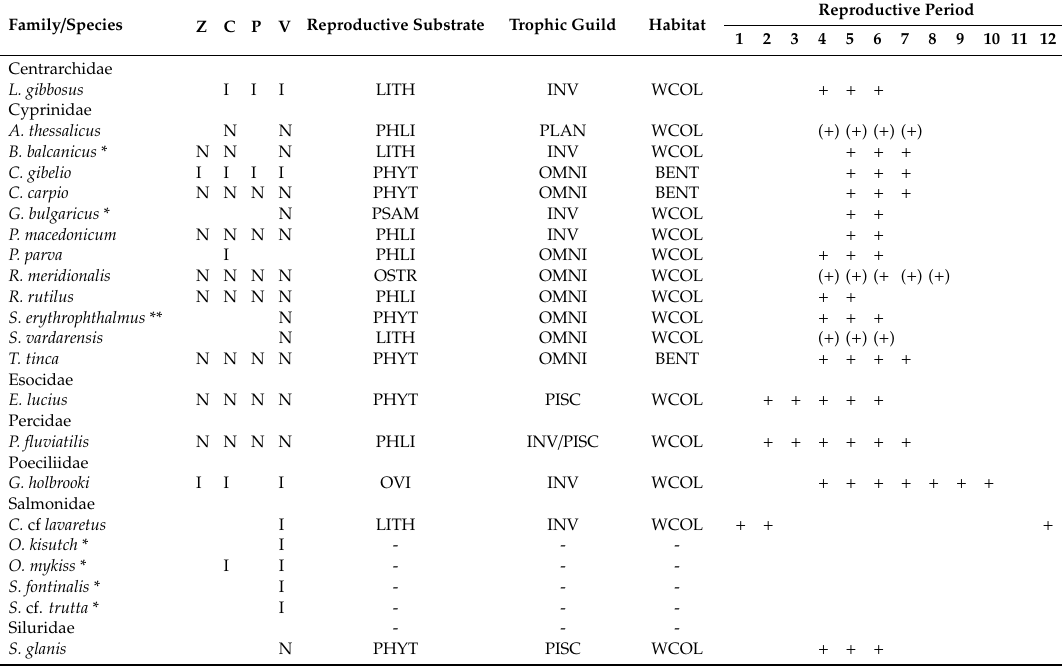
Table 5. Fish species reported in lakes Zazari (Z), Chimaditida (C), Petron (P), and Vegoritida (V). Some characteristics of their life history traits are also